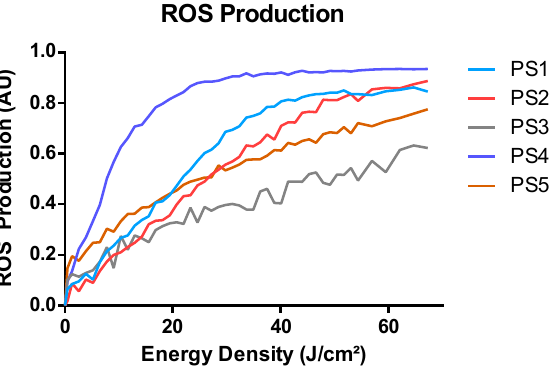
Figure 3. Photoactivated production of ROS by the candidate photosensitizers ( PS1 to PS5 , 40 μ M in water) expressed as arbitrary units (AU).